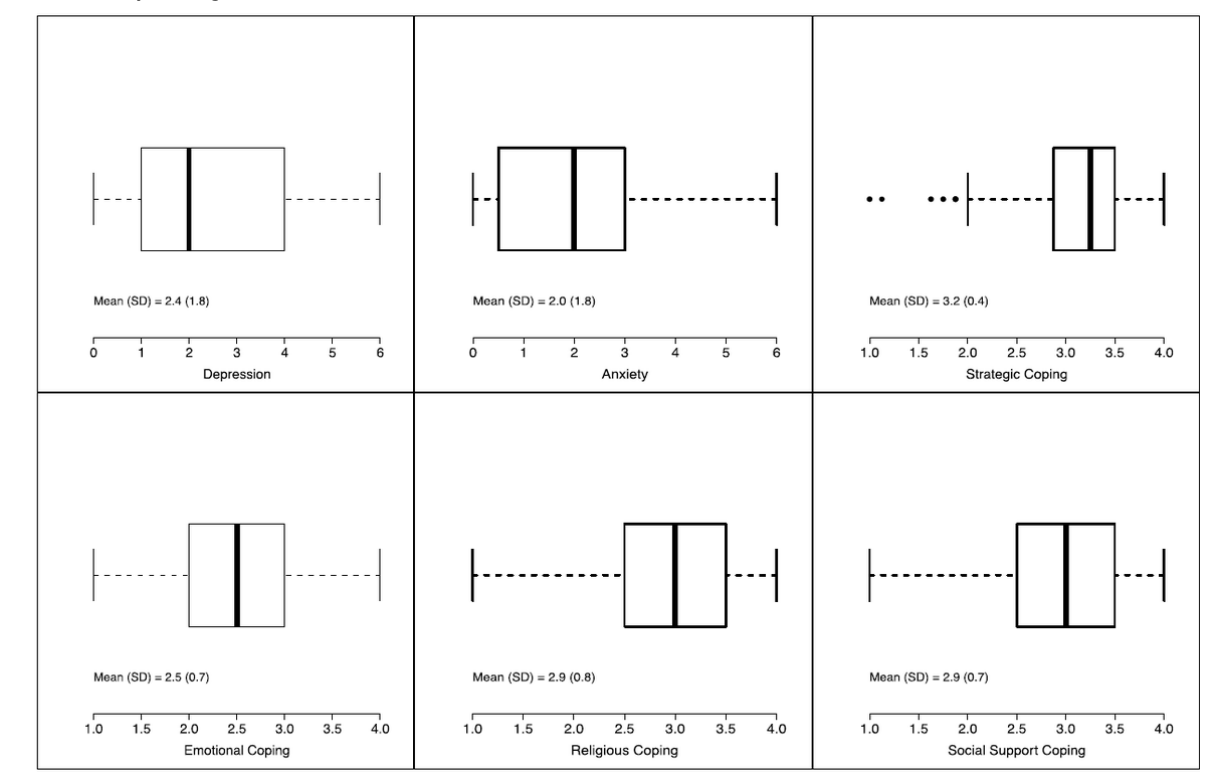
Figure 2. Summary of caregiver mental health